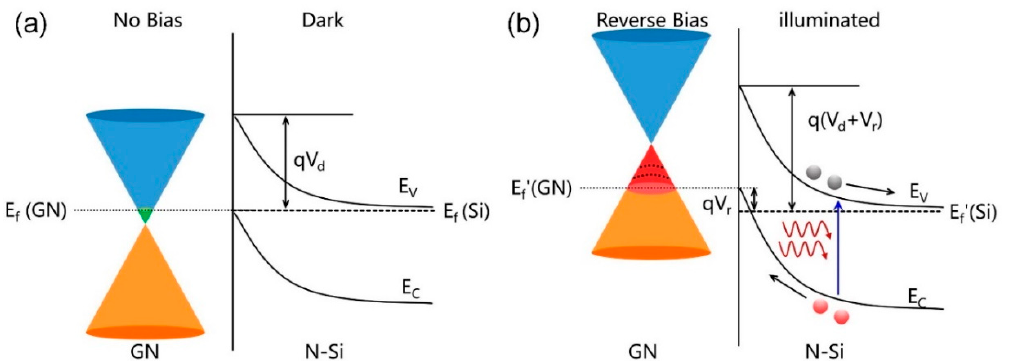
Figure 6. ( a ) Energy band structure diagram of the GNEC film/n-Si heterojunction at zero bias in the dark state. ( b ) Energy band structure diagram of the GNEC film/n-Si heterojunction under reverse bias in illumination.